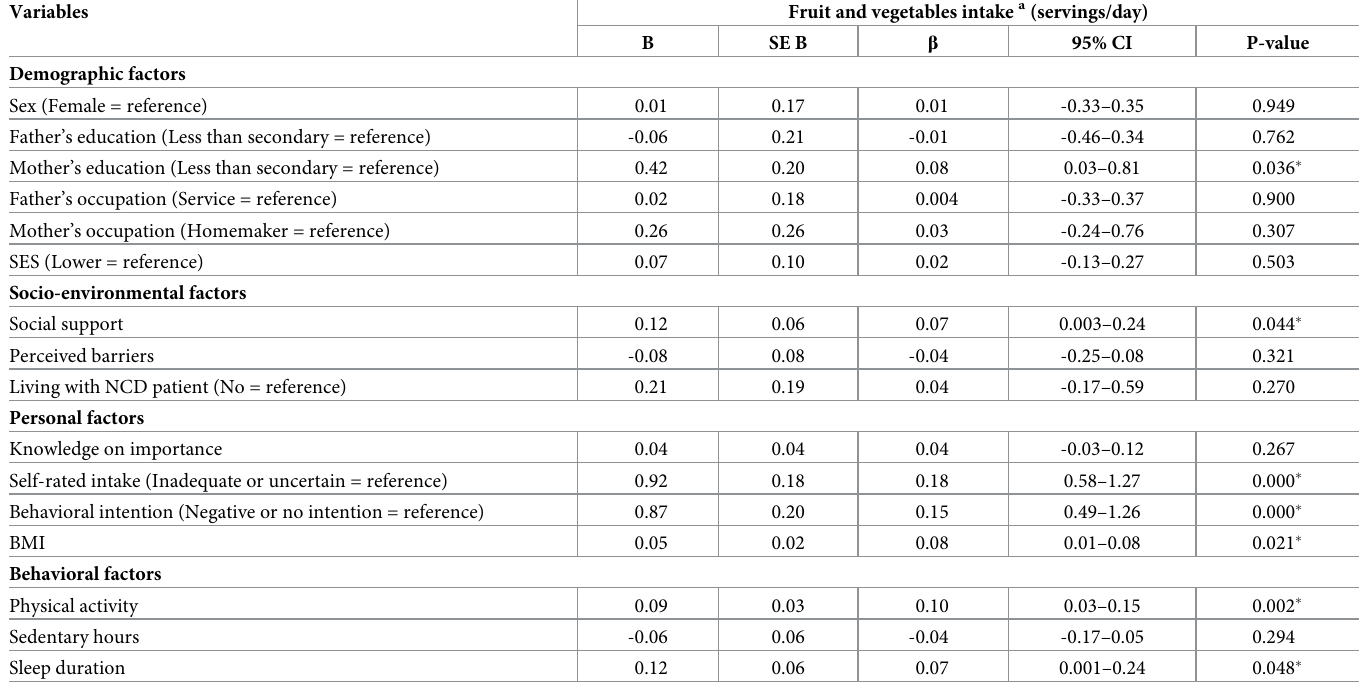
Table 4. Association of socio-environmental, personal, and behavioral factors with fruit and vegetables intake among